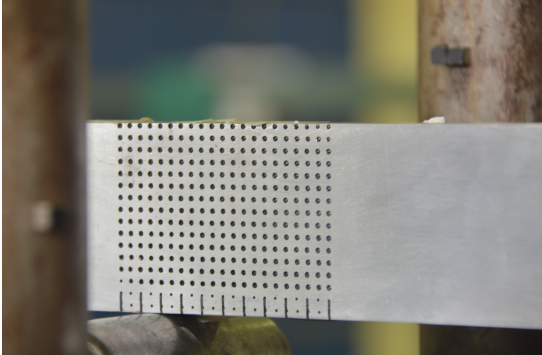
Figure 7. Circles monitored by the proposed